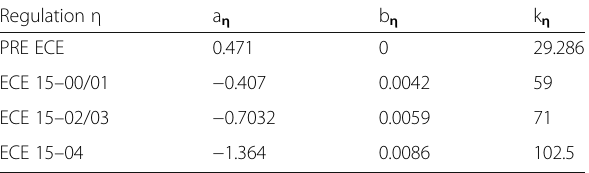
Table 3 parameter of the Corinair model for fuel consumption of cars on